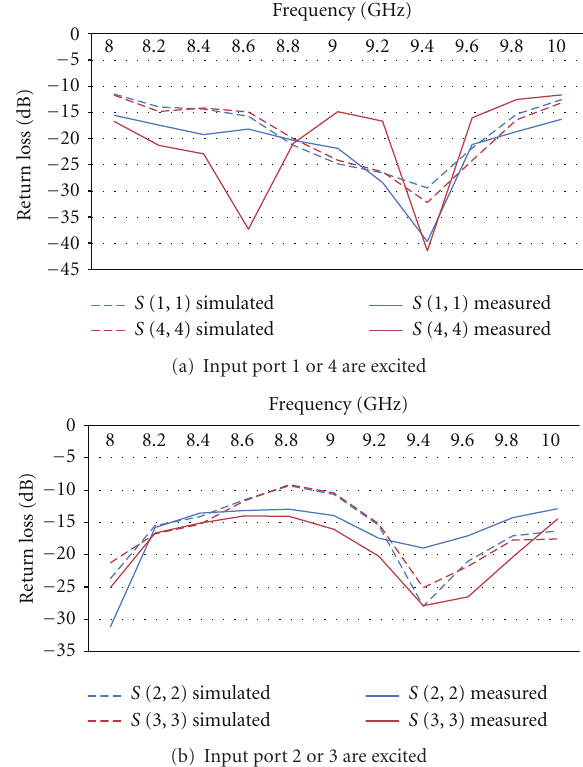
Figure 12: Return loss of the proposed Butler Matrix when di ff erent ports are